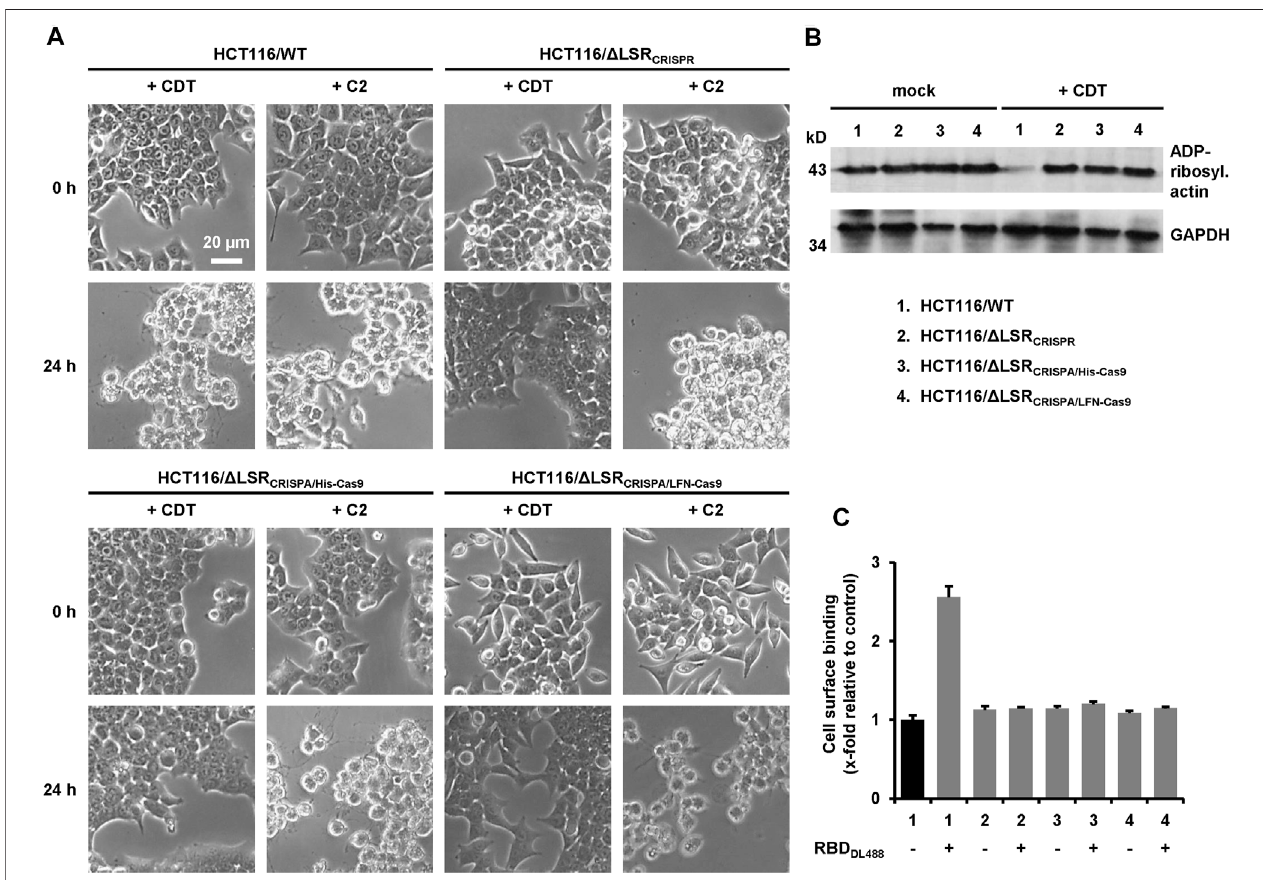
FIGURE 4 | Characterization of LSR-de fi cient HCT116 cells with CDT. (A) Wildtype HCT116 cells (HCT116/WT) as wells as LSR-de fi cient HCT116/ Δ LSR CRISPR , HCT116/ Δ LSR CRISPA/His-Cas9 and HCT116/ Δ LSR CRISPA/LFN-Cas9 cells were intoxicated with CDT (5 nM CDTa/1 nM CDTb) or C2 toxin (1 nM C2I/1.67 nM C2II) and imageswereobtainedmicroscopically after0and 24 htomonitor morphologicalchanges(cell rounding)ofthecells.Ascalebarrepresentativeforallimagesisshown in the upper left image (B) Wildtype and LSR-de fi cient HCT116 cells as described in the legend of numbers were intoxicated for 24 h with CDT (5 nM CDTa/1 nM CDTb)orwereleftuntreated(mock),followedbyasequentialADP-ribosylationassay.ImmunodetectionofGAPDHservedasloadingcontrol (C) BindingofDyLight488- labeled CDTb-RBD (RBD DL488 ) on wildtype and LSR-de fi cient HCT116 cells as described in the legend of numbers in (B) was analyzed via FACS and fl uorescence intensity (cell surface-binding) is shown in the bar diagram ( n (cid:2) 3, ± SD) as x-fold relative to control (black bar; mock-treated wildtype HCT116 cells), which was set to 1.